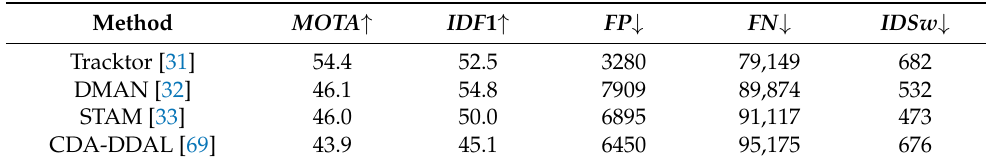
Table 2. Results of public detectors on MOT16 dataset (online methods).